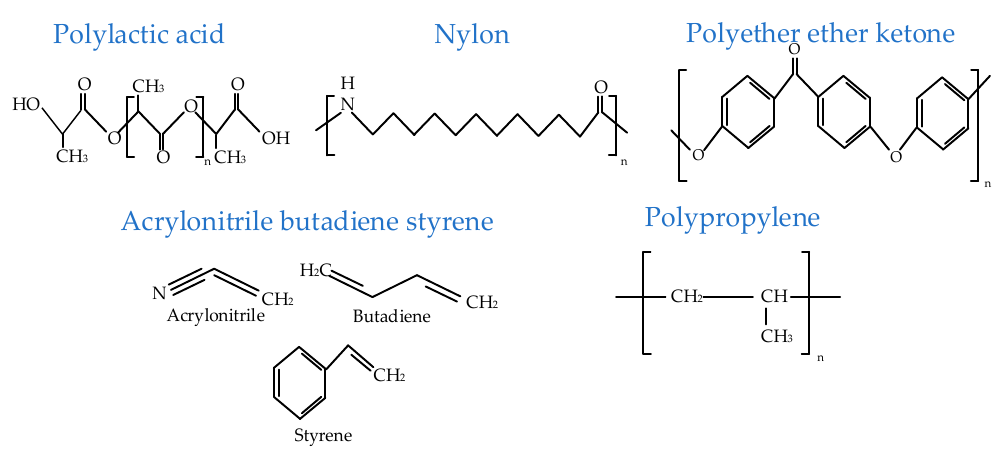
Figure 18. Chemical formulae of common FFF materials.